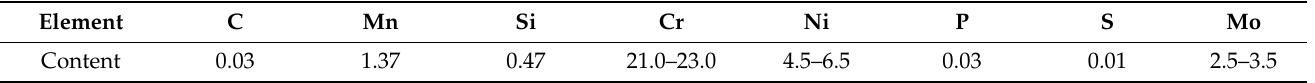
Table 1. Composition of UNS S31803 (wt %)